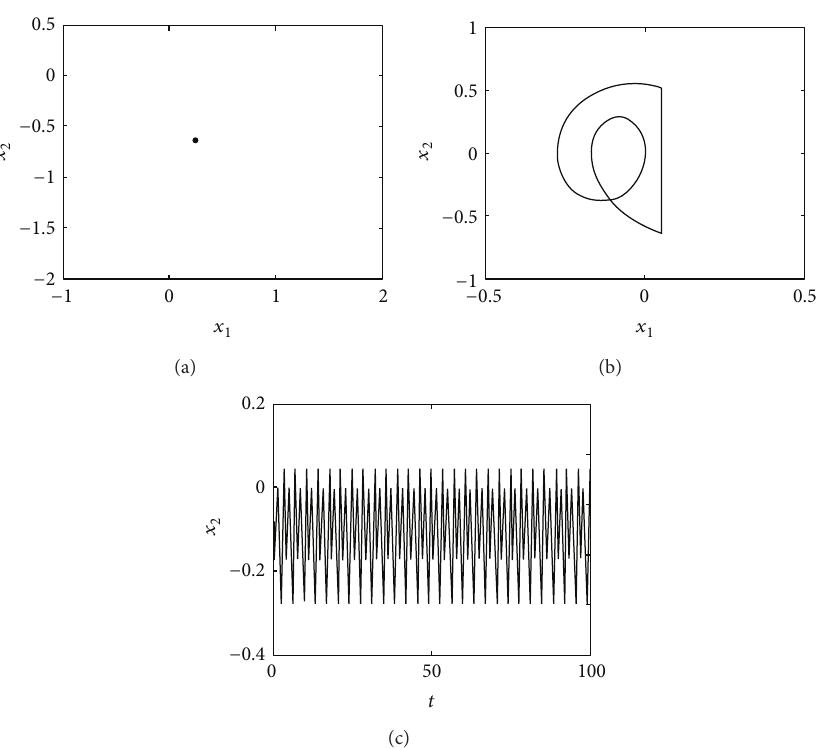
Figure 9: Poincar ´ e map, phase portrait, and time course diagram of the controlled system with 𝛾 = 0.05 and ℎ = 4.6